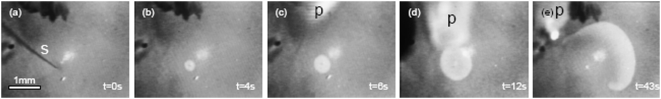
Creation of an SD wave segment with free open ends in submerged chicken retina.(a) Mechanical stimulation with sharp glass needle s, (b) circular SD wave evolves, (c)–(d) local application of Mg2+ via pipette p, (e) wave propagation is locally blocked and consequently SD front brakes open and curls in to form a spiral at the lower open end, while the upper open end is guided by the Mg2+-pipette to the border of the retina where it attaches.